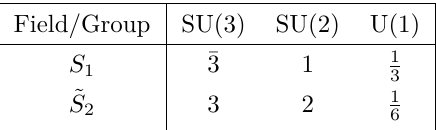
Table 2 . Leptoquark charges under the SM gauge group for the S 1 +